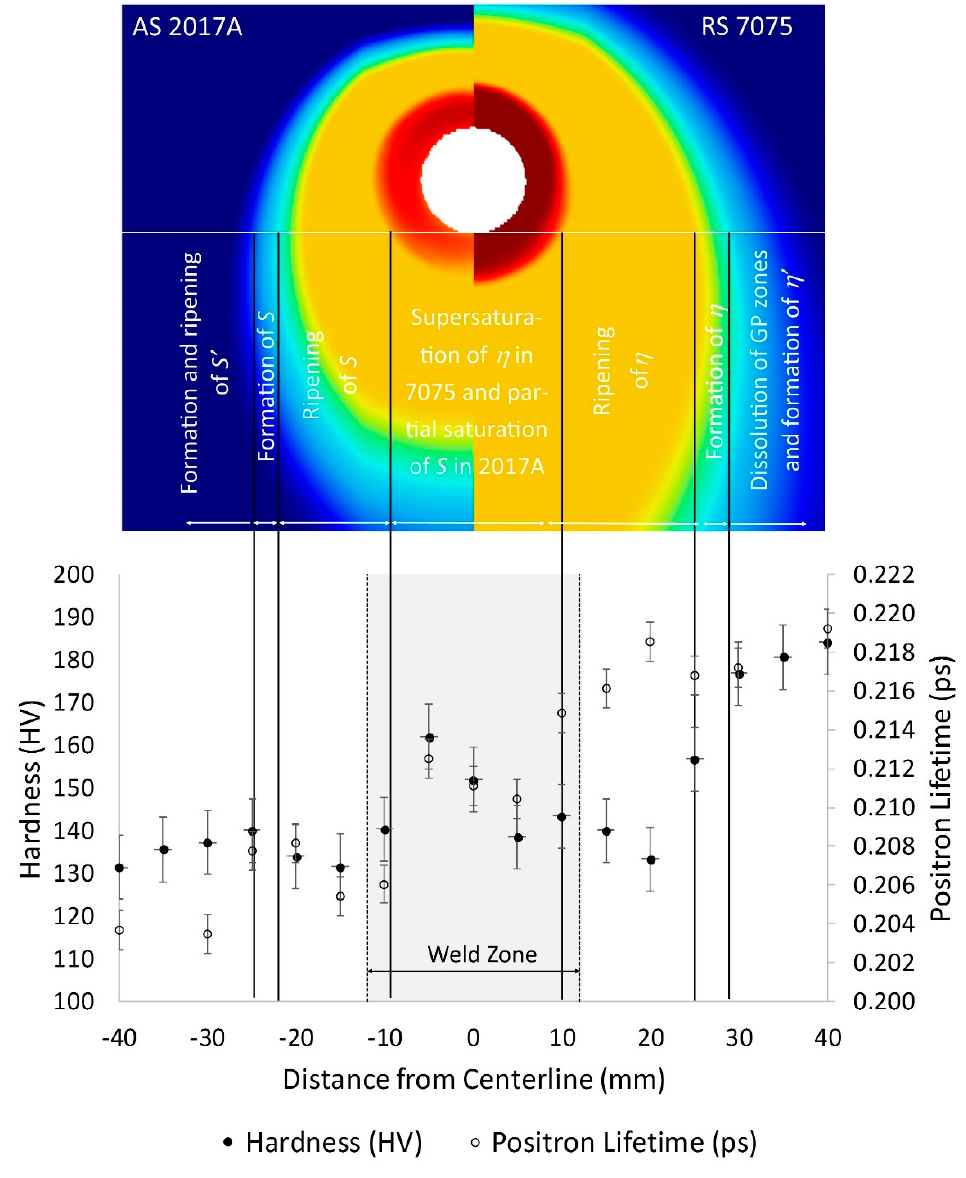
Figure 7. Phase transformation maps overlaid on lifetime/hardness profiles for the AS 2017A/RS 7075 configuration. Boundaries between phase transformation regions align with transition areas in both hardness and positron lifetime.